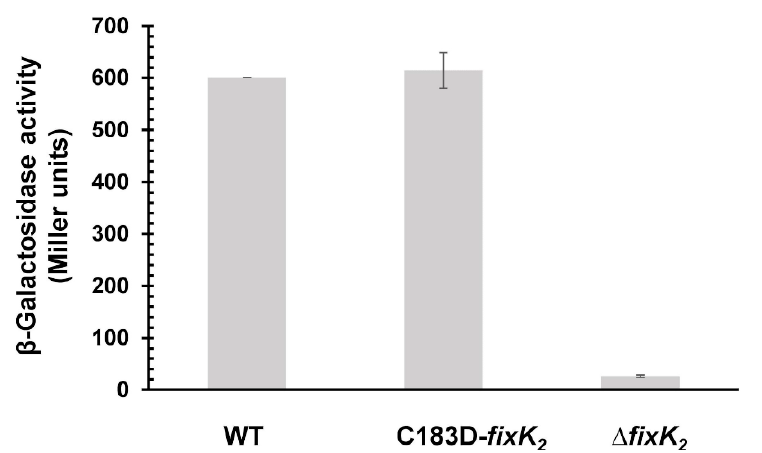
Figure 4. Expression data for a chromosomally integrated fixNOQP’-’lacZ fusion in different B. diazoefficiens backgrounds. Wild-type, C183D- fixK 2 and Δ fixK 2 strains were cultivated for 48 h microoxically (0.5% O 2 ). β -Galactosidase values are means ± standard errors of a representative experiment performed with two parallel cultures assayed in quadruples. The experiment was repeated at least twice. WT, wild type.